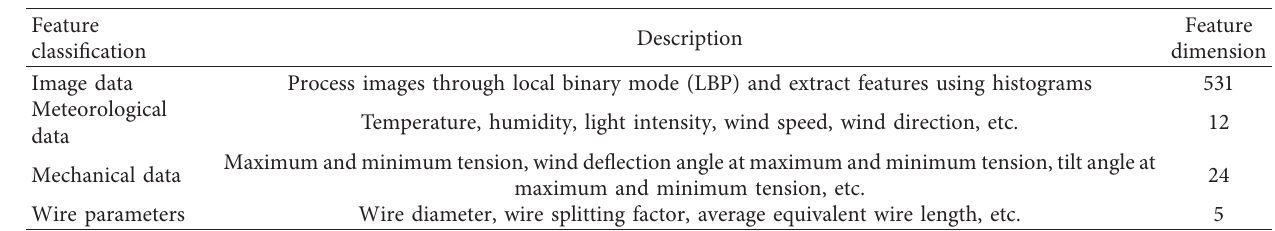
Figure 3: Examples of original image data. Table 1: Experimental data description.